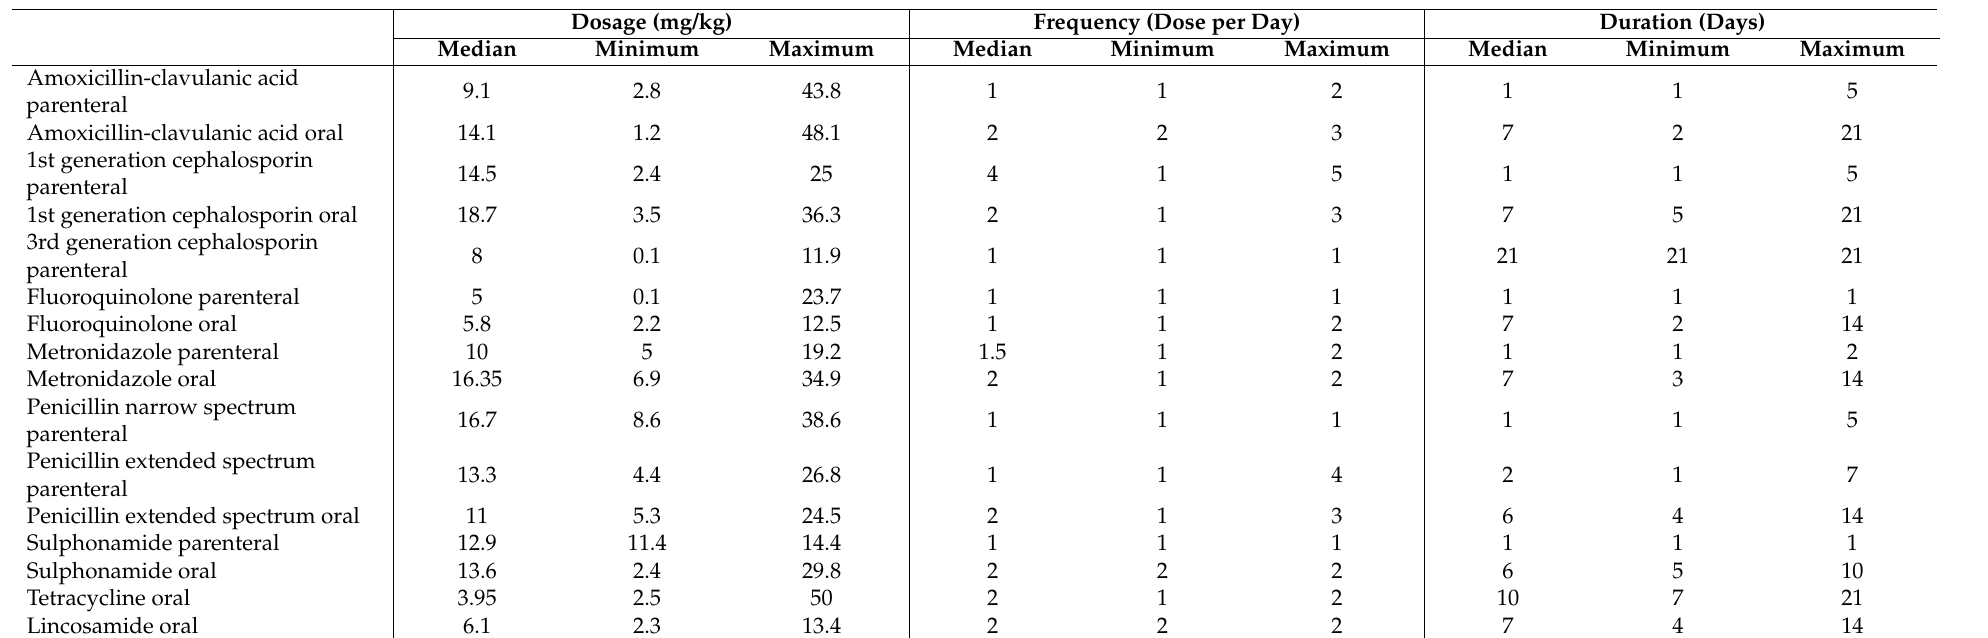
Table 3. Antimicrobial dosage, frequency, and duration of administration prescribed to treat dog-to-dog bite wounds in 1713 dogs, which presented for treatment between 1998 and 2018. Dosage